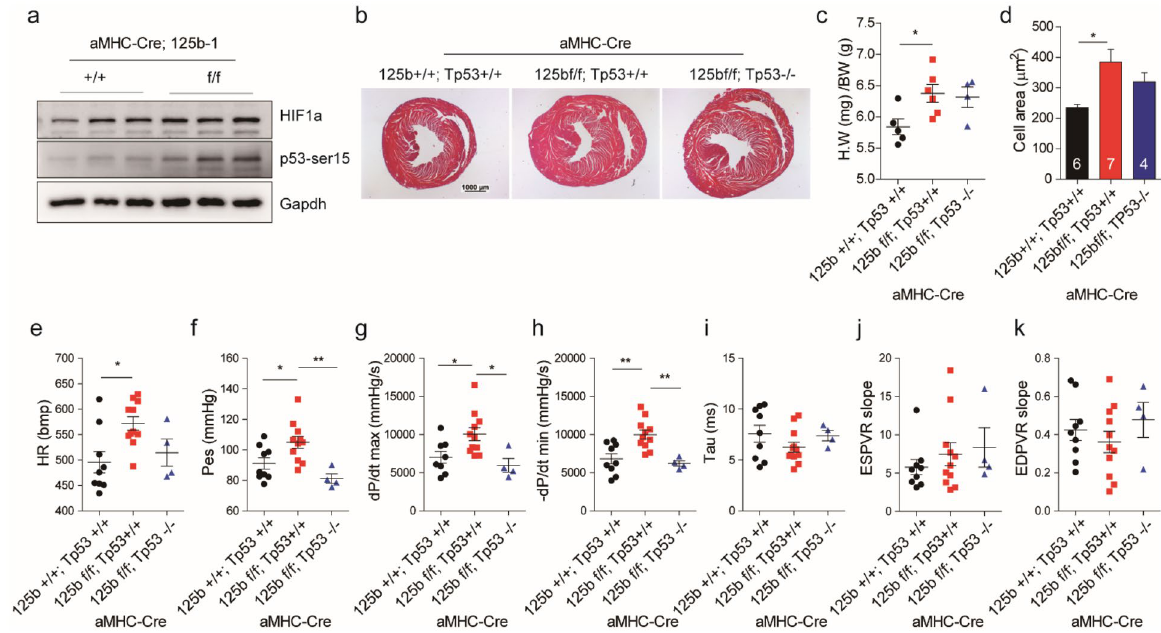
Figure 6. Knockout of Tp53 rescued the increase of heart rates and end systolic pressure in cardiac miR-125b deficient mice, but not cardiac hypertrophy phenotype. ( a ) Expression of HIF1a and p53 ser15phosphorylation in wild-type and miR-125b knockout neonatal hearts. The original images are displayed in Fig. S5. HIF1a, p53 ser15phosphorylation and Gapdh were from different blots with the same protein extracts. ( b ) HE staining of hearts in the control (125b + / + ; Tp53 + / +), miR-125b knockout (125bf/f; Tp53 + / +) and miR-125b/Tp53 double knockout (125bf/f; Tp53−/−) mice. Bar: 1 mm. ( c ) Heart weight-to-body weight ratio in the control, miR-125b knockout and miR-125b/Tp53 double knockout mice (n = 5, 6 and 4. control vs. miR-125b knockout, p = 0.0450; control vs. double knockout, p = 0.1146; miR-125b knockout vs. double knockout, p = 0.9549). ( d ) Cardiomyocyte size in the control, miR-125b knockout and miR-125b/Tp53 double knockout mice (n = 6, 7 and 4. control vs. miR-125b knockout, p = 0.0112; control vs. double knockout, p = 0.2536; miR-125b knockout vs. double knockout, p = 0.4138). ( e ) The heart rate (control vs. miR-125b knockout, p = 0.0116; control vs. double knockout, p = 0.8295; miR-125b knockout vs. double knockout, p = 0.1760), ( f ) end-systolic pressure (control vs. miR-125b knockout, p = 0.0363; control vs. double knockout, p = 0.3478; miR-125b knockout vs. double knockout, p = 0.0055), ( g) dP/dt maximum (control vs. miR-125b knockout, p = 0.0396; control vs. double knockout, p = 0.7684; miR-125b knockout vs. double knockout, p = 0.0265 ), ( h ) dP/dt minimum (control vs.vs. miR-125b knockout, p = 0.0028; control vs. double knockout, p = 0.8520; miR-125b knockout vs. double knockout, p = 0.0058), ( i ) Tau (control vs. miR-125b knockout, p = 0.2908; control vs. double knockout, p = 0.9843; miR-125b knockout vs. double knockout, p = 0.5825), ( j ) the slope of end-systolic pressure volume relationship (control vs. miR-125b knockout, p = 0.6666; control vs. double knockout, p = 0.5919; miR-125b knockout vs. double knockout, p = 0.9349) and ( k ) the slope of end-diastolic pressure volume relationship (control vs. miR-125b knockout, p = 0.7139; control vs. double knockout, p = 0.8718; miR-125b knockout vs. double knockout, p = 0.5113) in control, miR-125b knockout and miR-125b/Tp53 double knockout mice (n = 9, 12 and 4). The significance of the differences among control, knockout and double knockout groups were determined by one-way ANOVA with Tukey’s multiple comparison The expression level of miR-125b changes under different cardiac pathological status. It is induced by angio- tensin II in cardiac fibroblasts 41 and upregulated in human failing hearts 29 . However, it is downregulated after